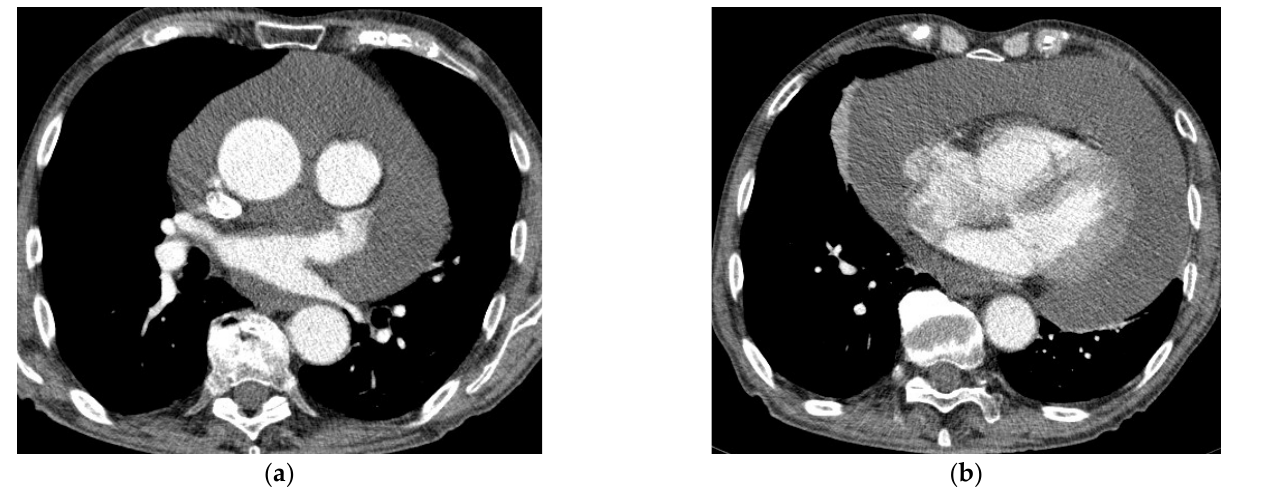
Figure 2. ( a , b ) Chest CT with contrast enhancement shows a large pericardial effusion. Chest MRI